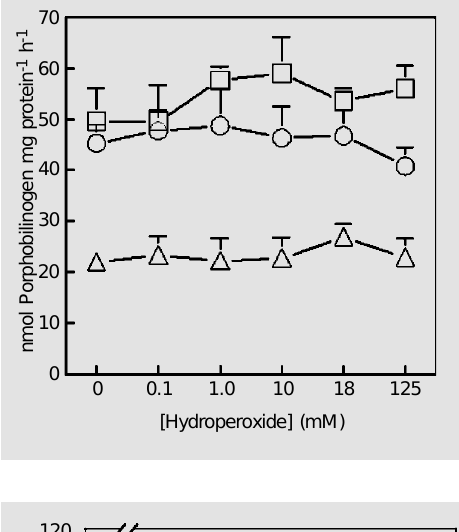
2. Effect of PhSeSePh on rat liver (A) and cucumber leaf (B) δ -ALA-D. Reaction